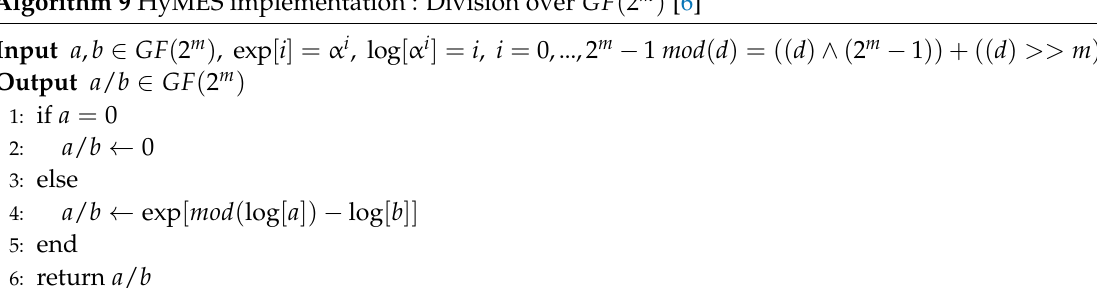
Algorithm 9 HyMES implementation : Division over GF ( 2 m )